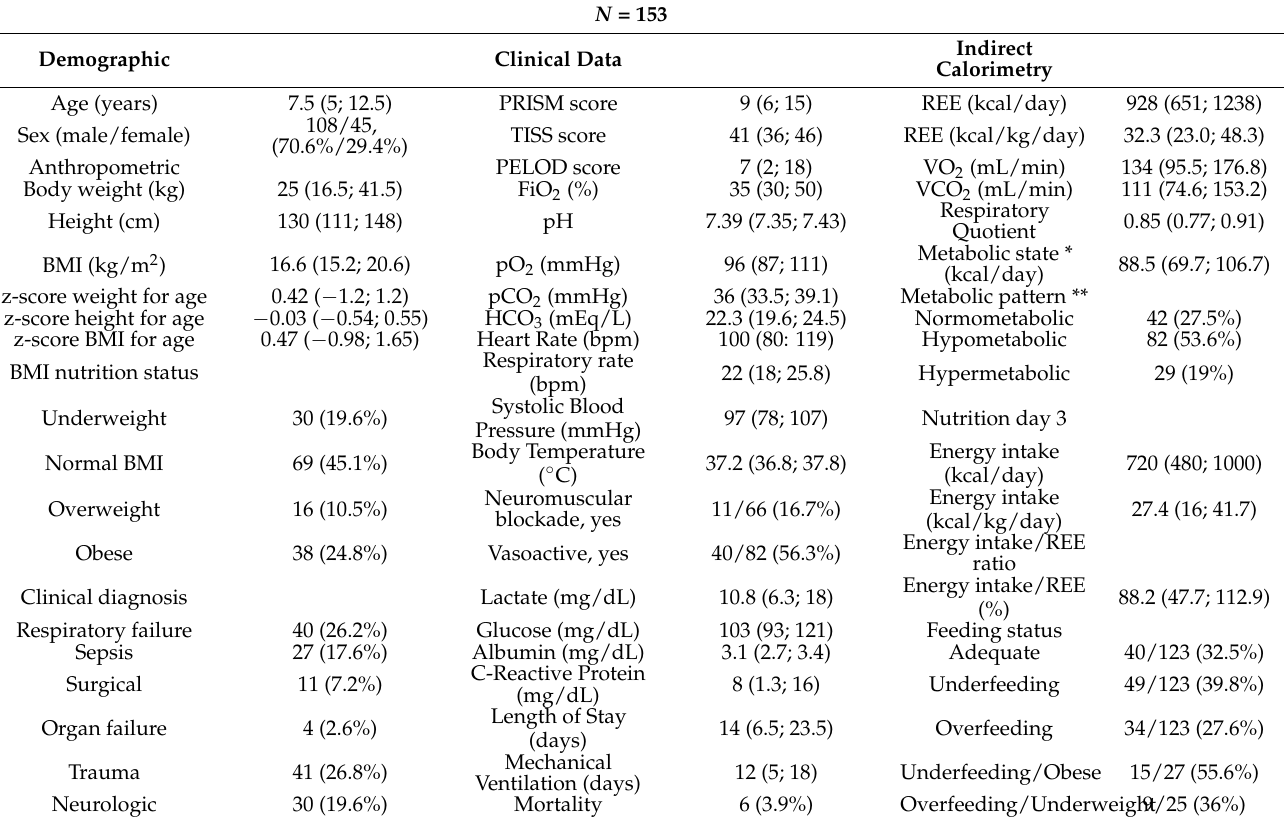
Table 1. Demographic and clinical